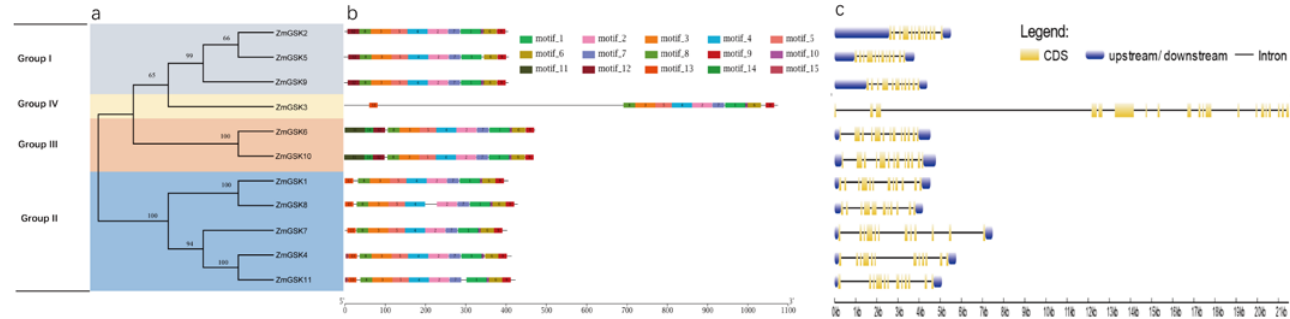
Figure 3. Phylogeny, exon–intron structures, and motif analysis of ZmGSKs. ( a ) Phylogenetic tree of ZmGSK. ( b ) Conserved motif analysis of ZmGSK OPF translations. Motifs were designated 1–10 and distinguished with different colors. ( c ) Exon–intron structures of ZmGSK genes. The full-length mRNA sequences of ZmGSK genes were analyzed and displayed. Coding sequences (CDSs) are represented by yellow boxes, untranslated regions (UTRs) are shown as blue boxes, and introns are represented by blank lines. The scale at the bottom represents lengths.